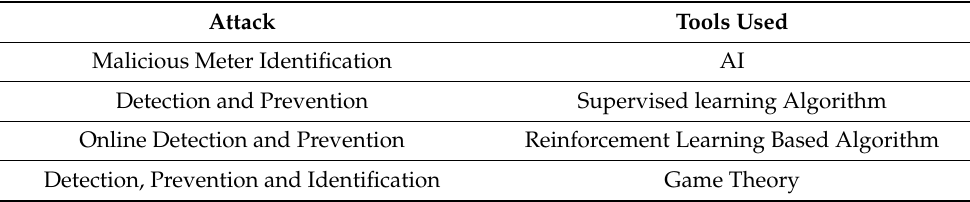
Table 3. Comparative analysis on